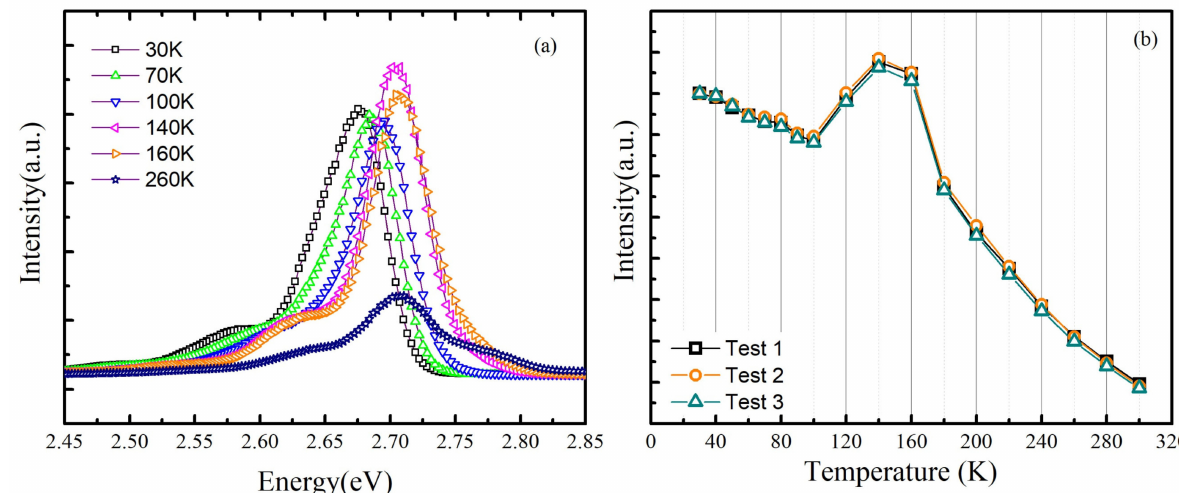
Figure 1. ( a ) The photoluminescence spectra at typical temperature of sample A; and ( b ) the normalized temperature- dependent integrated Photoluminescenceintensity of three repeated tests of sample A.